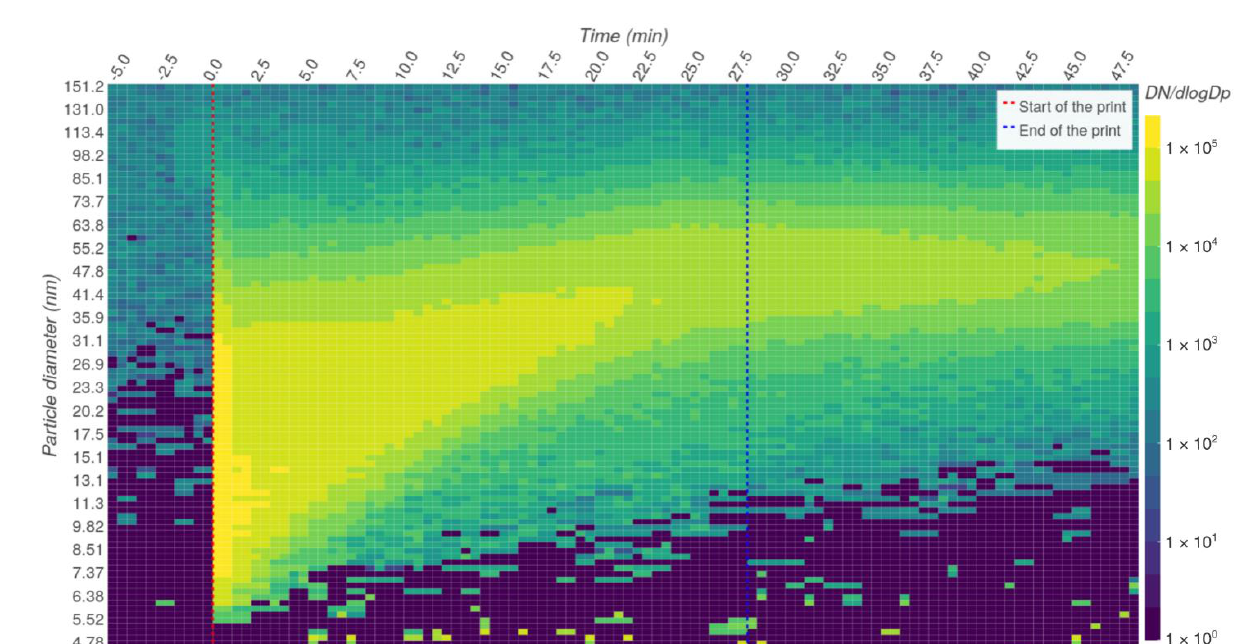
Figure 4. Example of the measured particle distribution. After that purge was completed, the printing job was sent to the printer, and the printer started to heat the printing nozzle and subsequently initiated the extrusion of the filament. In the first few minutes of the printing, the value of total particle concentration commonly reached its maximum, as shown in the example of printing PET-G at 250 °C with a 0.4 mm nozzle (Figure 5).